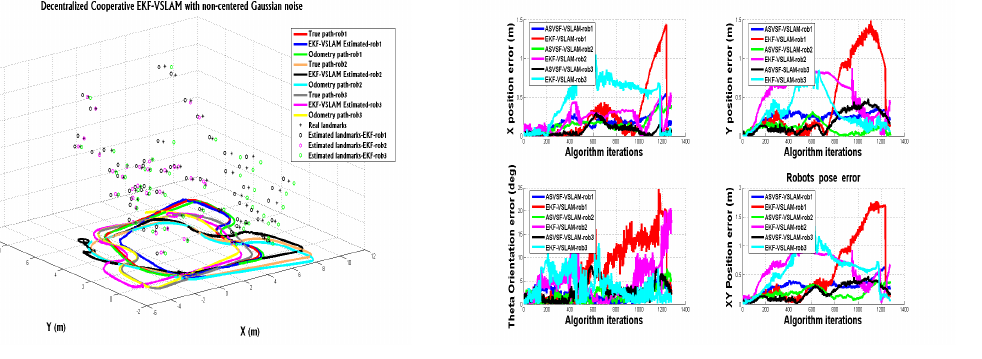
Fig. 8: Visual EKF-SLAM simulation results with non- centered Gaussian noise.